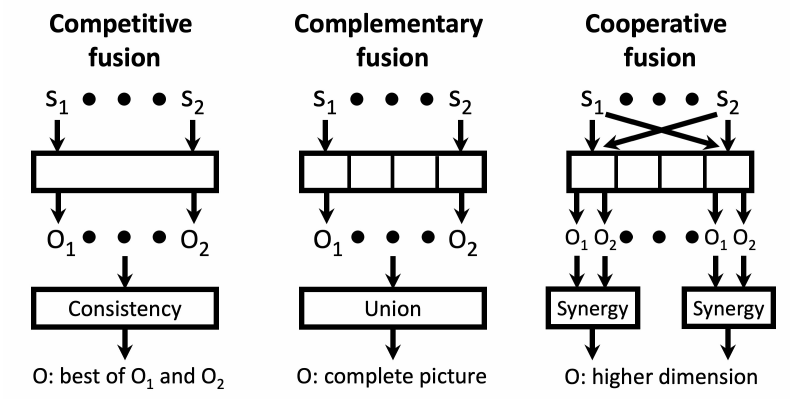
Figure 2. Data fusion characterization based on sensor relations.